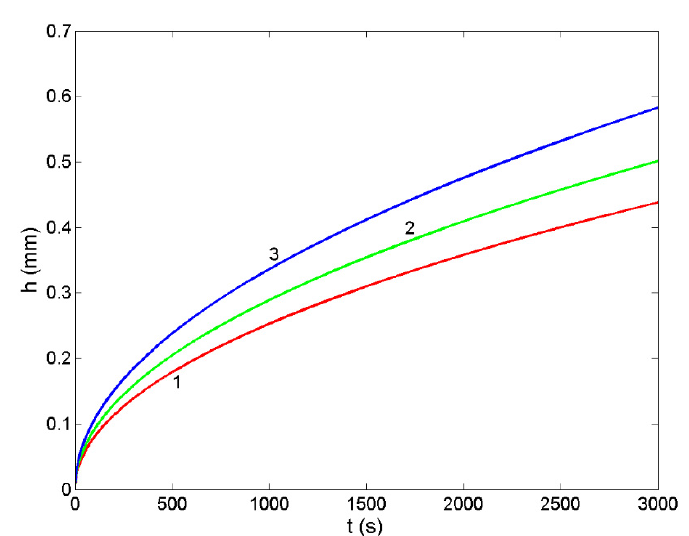
Figure 9. Infiltration depth of liquid Ir-80.5Si (at %) eutectic alloy into a porous SiC-substrate with pore sizes (in µ m) of r = 65 (curve 1), r = 85 (curve 2) and r = 1.15 (curve 3), calculated for T = 1873 K by Washburn’s equation.